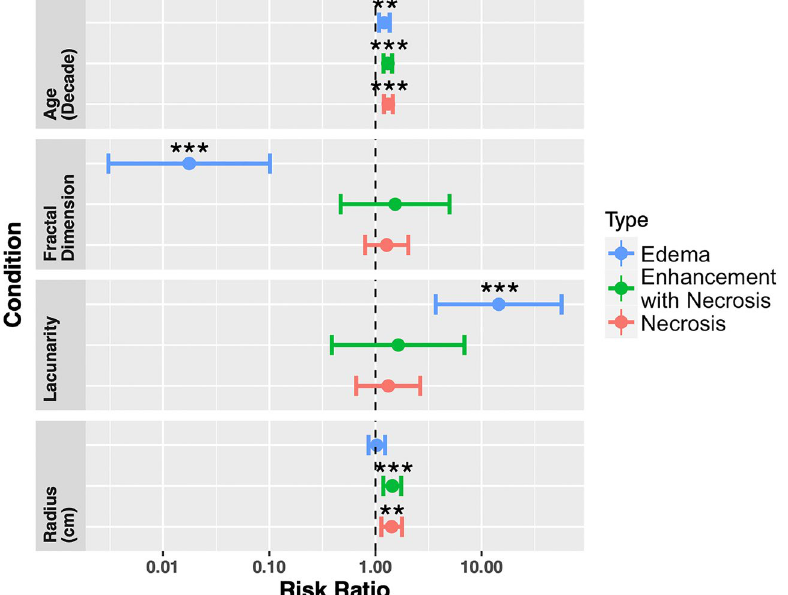
Figure 4. Univariate Cox proportional hazard models for age at diagnosis, fractal dimension, lacunarity and tumor radius, across all three regions (necrosis n = 390, enhancement with necrosis n = 402, edema n = 257). Both fractal dimension and lacunarity of edema-related abnormalities are significant prognostic indicators of overall survival. Age at diagnosis was significant for all three regions, while radius was significant for both necrosis and enhancement with necrosis. Values of these tests can be found in Supplement